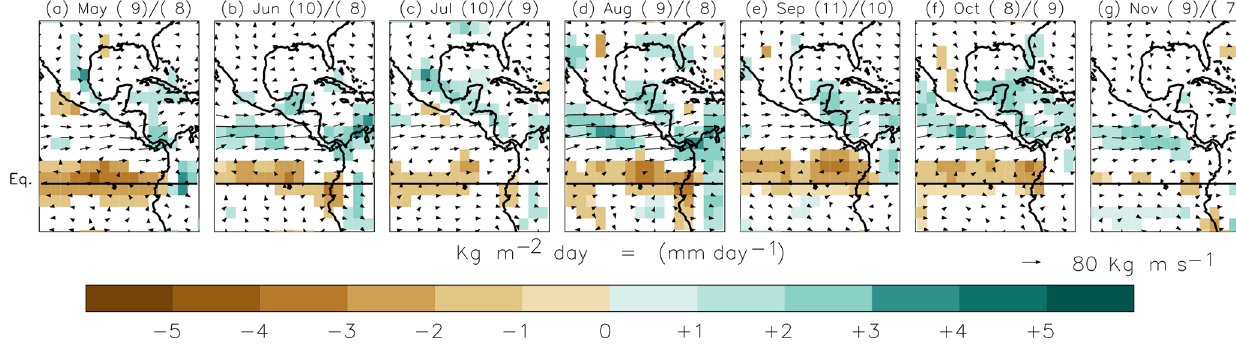
Figure 8. Vertically integrated moisture transport between 1000 and 850hPa (arrows; scale at the lower-right corner) and moisture con- vergence (shaded areas) differences between CHOCO-D + / − 0 . 75 standard deviations, years for the 1979–2014 period and NCEP-NCAR reanalysis data. Only moisture convergence differences significant at p < 0 . 05 are represented. The number of CHOCO-D positive/negative cases used to compute the anomalies is indicated in